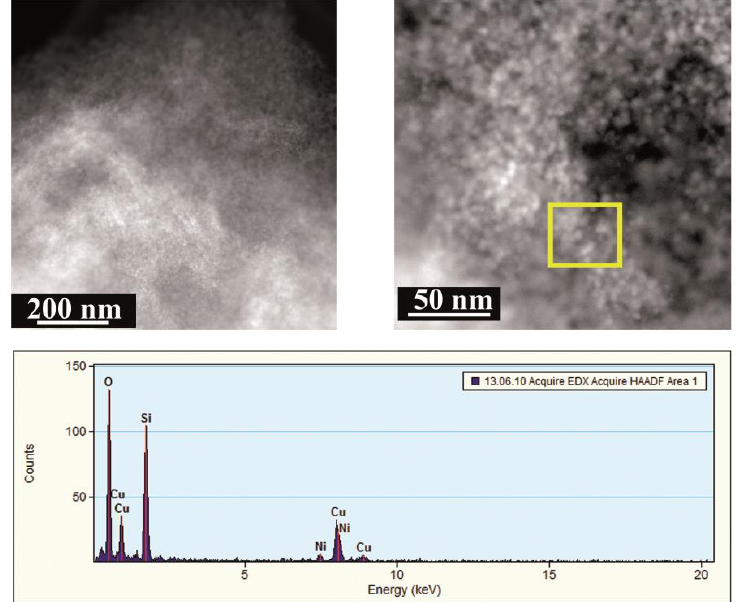
Figure 7. HAADF STEM images of the fresh CuAsc / SiO 2 catalyst and representative EDX spectrum of a selected area.